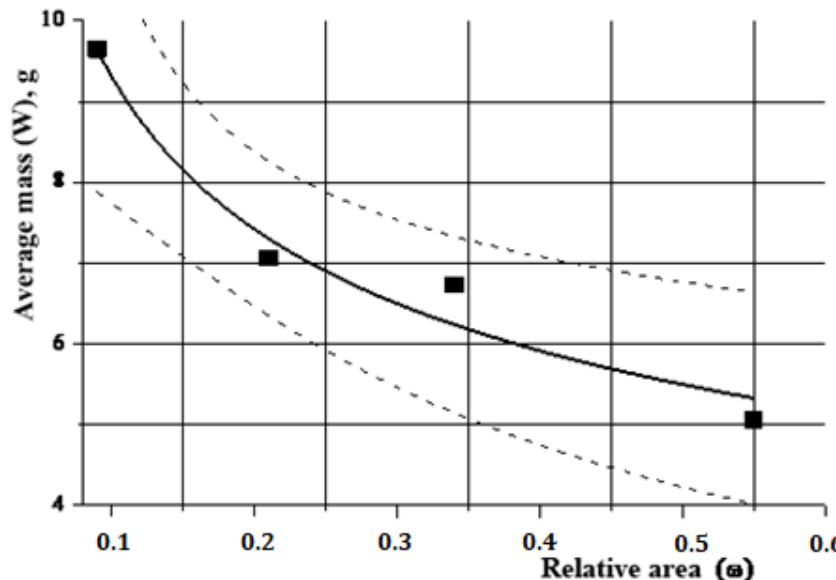
Figure 6. Change in average mass (W) of mussels on different types of collectors during cultivation; the thickened line is a theoretical curve according to Equation (7), the dashed lines represent 95% confidence interval.